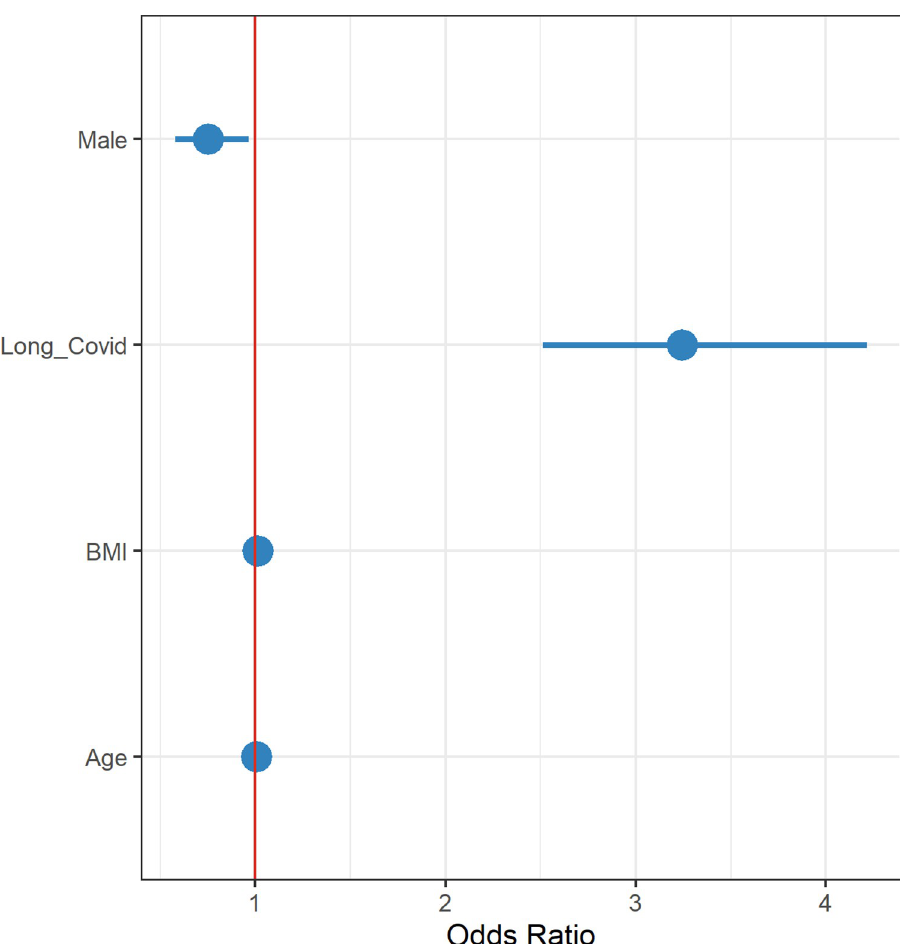
Fig 3. Analysis of 378 patients that used further health services. Suffering from Post-COVID-19 syndrome was the leading factor requiring any further health services